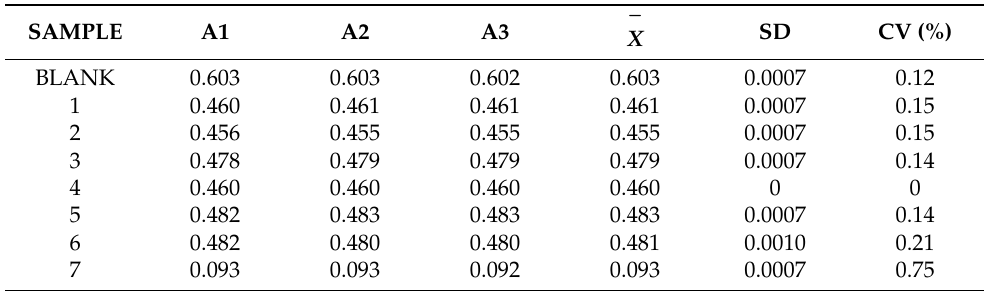
Table 17. Absorbances obtained for hydrophilic extracts of cream samples (ferroion chelation method with ferrosine).